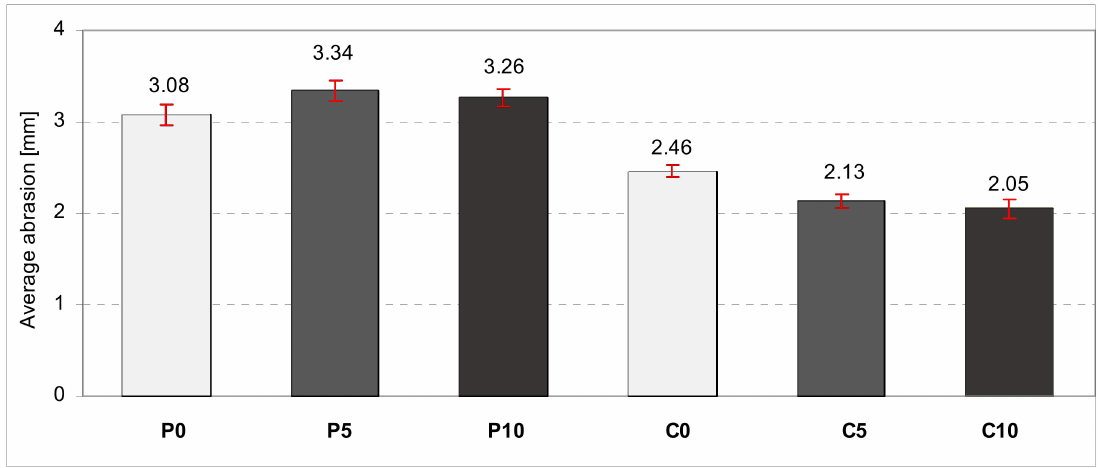
Figure 11. The average values with standard deviations referring to the abrasion of concrete